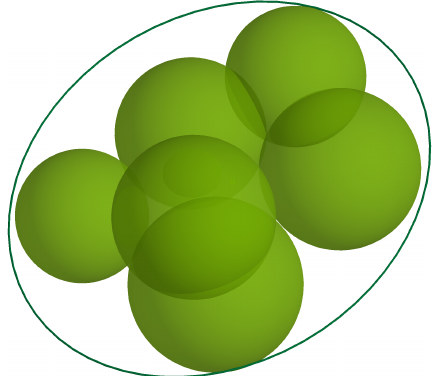
Figure 6. COSIMA model results for the coagulation rate of the SOA particles during experiment RUN2 at − 10 ◦ C. The particle number concentration was integrated from the SMPS measurements between 20 and 500nm.